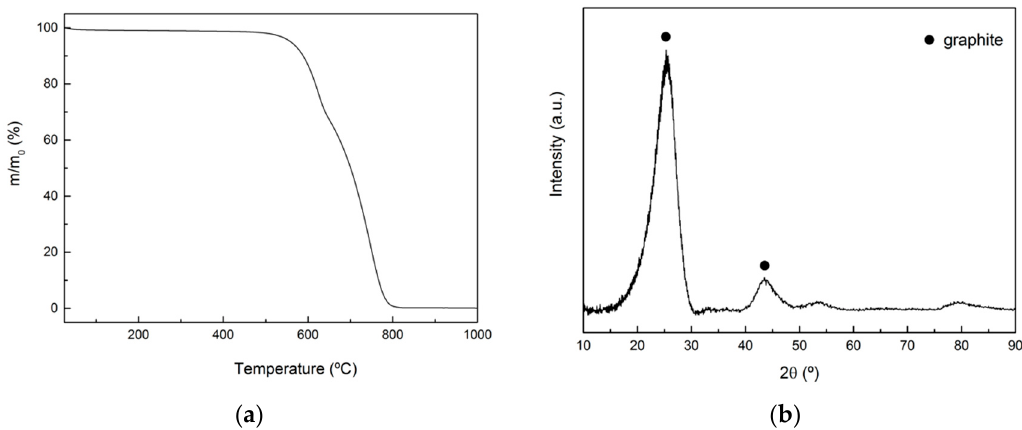
Figure 3. ( a )Thermogram of the C f /C preform in oxidizing atmosphere (N 2 :O 2 = 4:1); ( b ) XRD pattern for the C f /C preform.